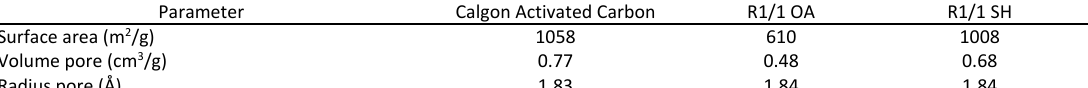
Table 6: Surface area BET, volume and pore diameter of the materials studied Parameter